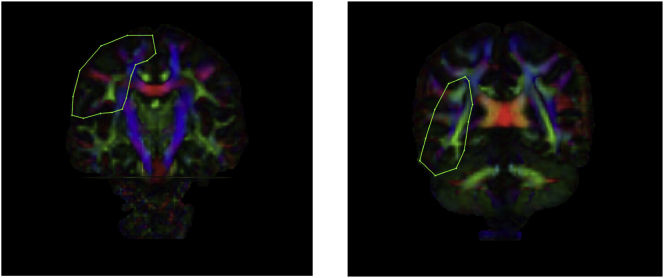
A visual representation of ROI masks for the SLF. NOTE: ROI: Region of interest; SLF- superior longitudinal fasciculus.